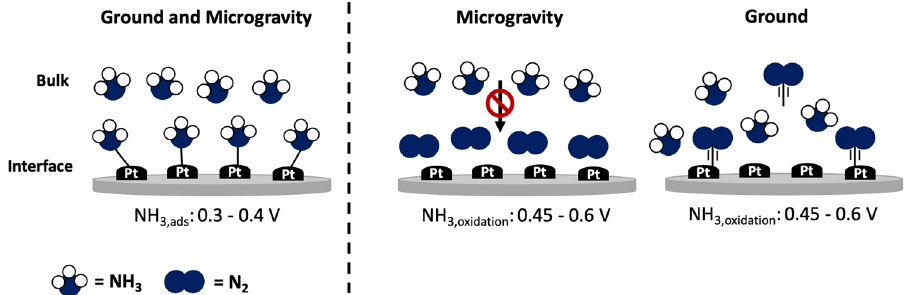
Fig. 4 Schematic illustration of the effect of microgravity on the electrochemical ammonia oxidation reaction. The absence of macroconvectional processes hinders the removal of N 2 (g) from the electrode surface and limits the interaction of ammonia with the Pt electrocatalyst. Redrawn from Nicolau et al. (2012) 29